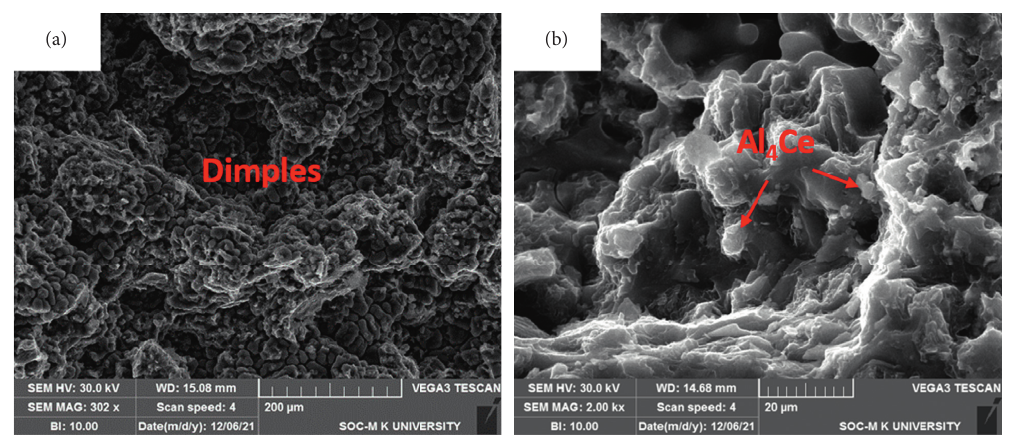
Figure 8: Fractography analysis of AZ91D +1.0wt.% Ce+1.0wt.%